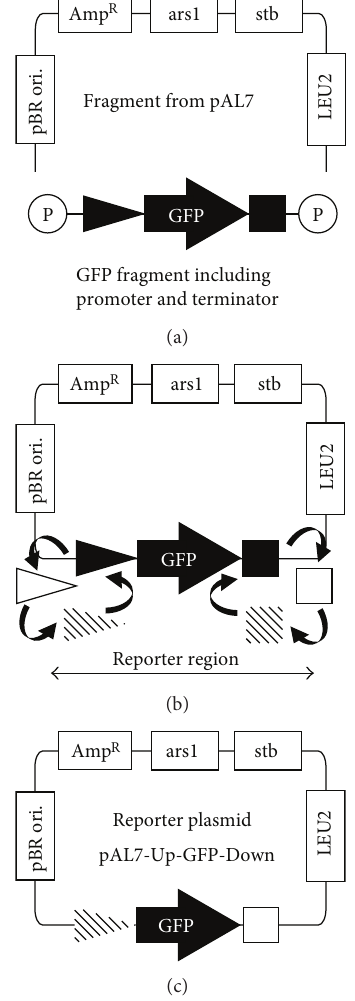
F 1: e schematic illustration of reporter plasmid construc- tion. (a) Ligation of the fragment ampli�ed from pAL7 and the phosphated fragment including a series of promoter, GFP (�lled arrow) and LPI terminator (�lled box). (b) Conversion of the promoter into any upstream regions (shaded and open triangles), and conversion of the LPI terminator into any downstream regions (shaded and open boxes). (c) Completion of converting upstream and downstream region. All reporter plasmids listed in Table 1 were constructed in this